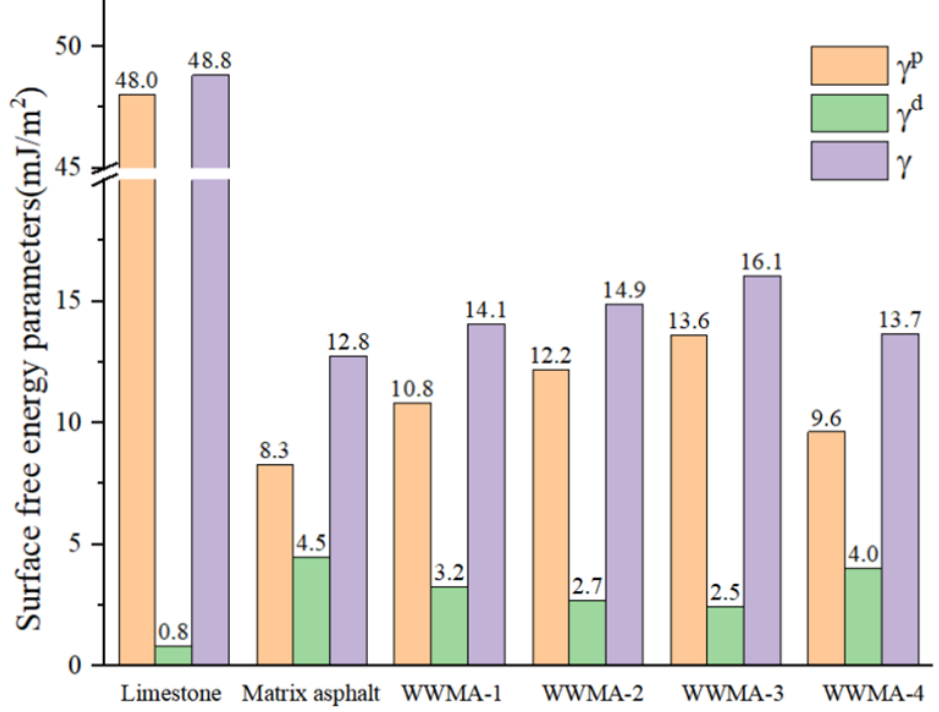
Figure 14. The surface free parameters of asphalt samples and limestone.